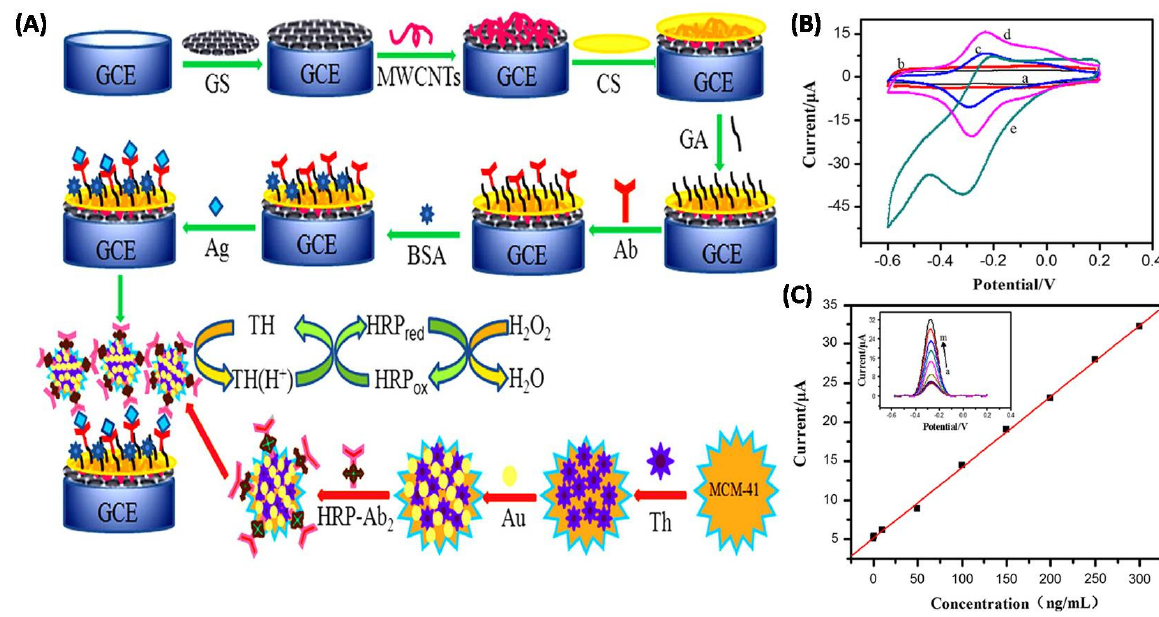
Figure 2. ( A ) Schematic depiction of the steps involved in the preparation of the immunosensor; ( B ) Cyclic voltammograms recorded at 50 mV/s for different electrode modifications: (a) Ab 1 /GA/CS/MWCNTs/GS/GCE, (b) PCT/Ab 1 /GA/CS/MWCNTs/GS/GCE, (c) HRP-Ab 2 /Au/TH/MCM-41/PCT/Ab 1 /GA/CS/GCE and (d) HRP- Ab 2 /Au/TH/MCM-41/PCT/Ab 1 /GA/CS/MWCNTs/GS/GCE in phosphate buffered saline of pH 7.0, and (e) HRP- Ab 2 /Au/TH/MCM-41/PCT/Ab 1 /GA/CS/MWCNTs/GS/GCE in medium containing 2 mM H 2 O 2 ; ( C ) Calibration plot obtained for the electrochemical immunosensor using known concentrations of PCT in PBS of pH 7.0 containing 2 mM H 2 O 2 , n = 5 for every concentration level in the same measurement run [21] .